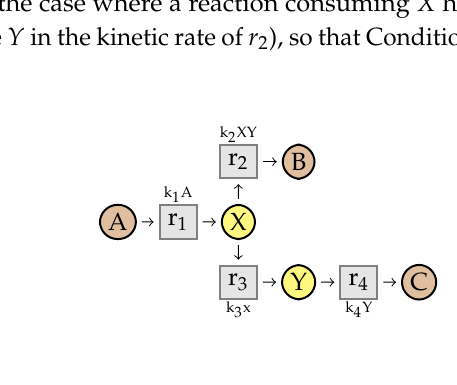
Figure 18. Example illustrating the need of Condition